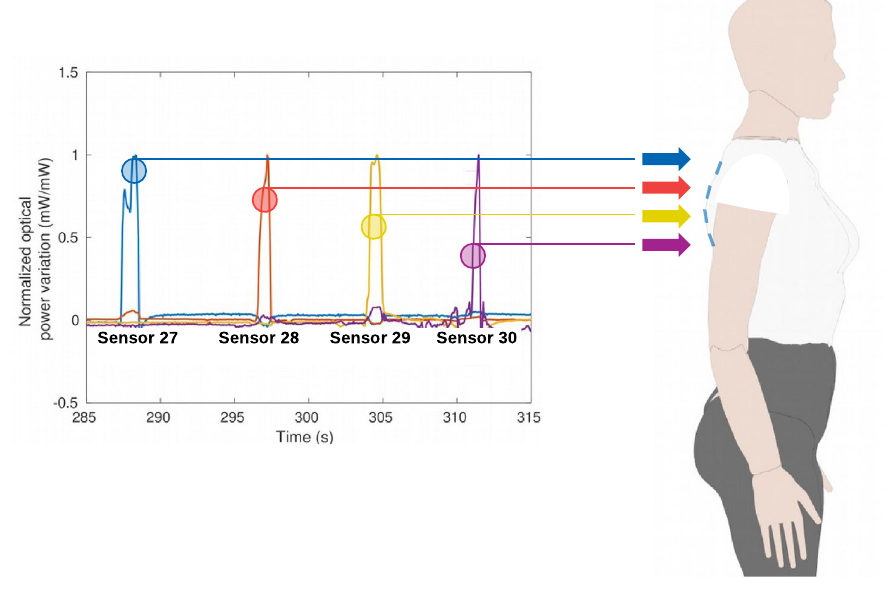
Figure 2. Response of sensors 27-30 when a predefined loading is applied to each